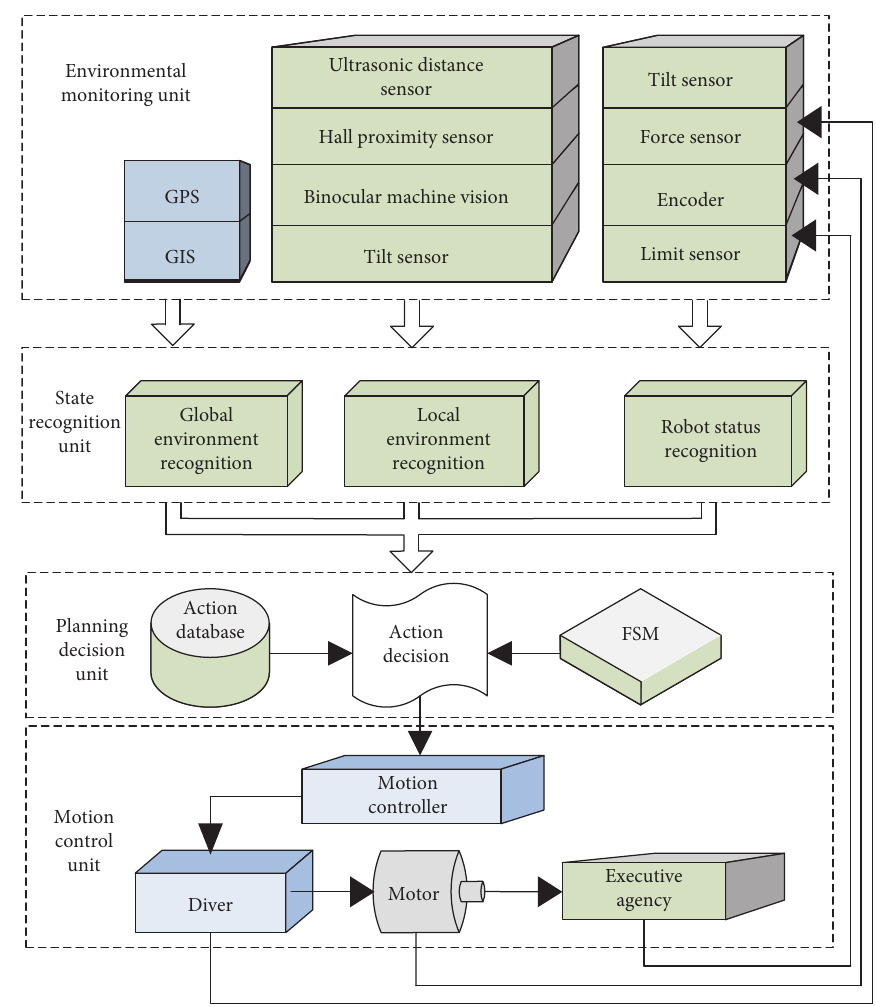
Figure 7: Robot schematic diagram of autonomous behavior